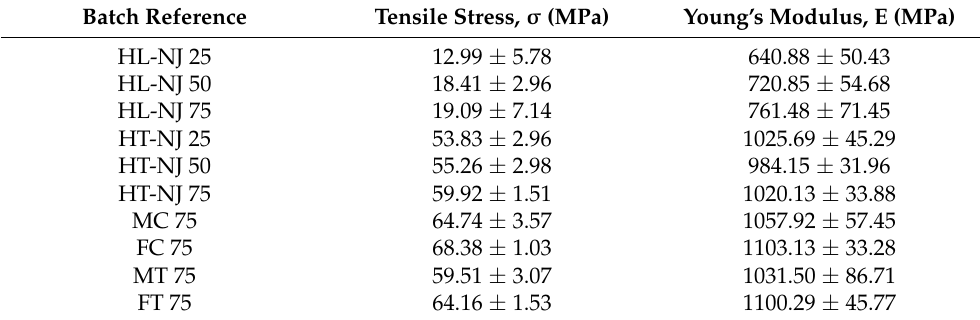
Table 4. Average tensile test results (tensile stress and Young’s Modulus) and their standard deviations for all HM